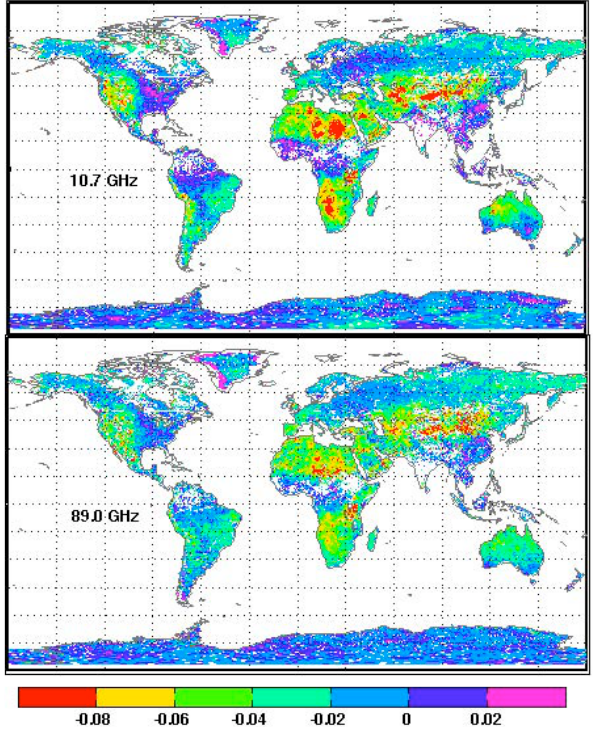
Fig. 8. Difference between ascending and descending monthly mean of AMSR-E emissivity at 10.7GHz (top), and 89.0GHz (bot- tom) in horizontal polarization for July